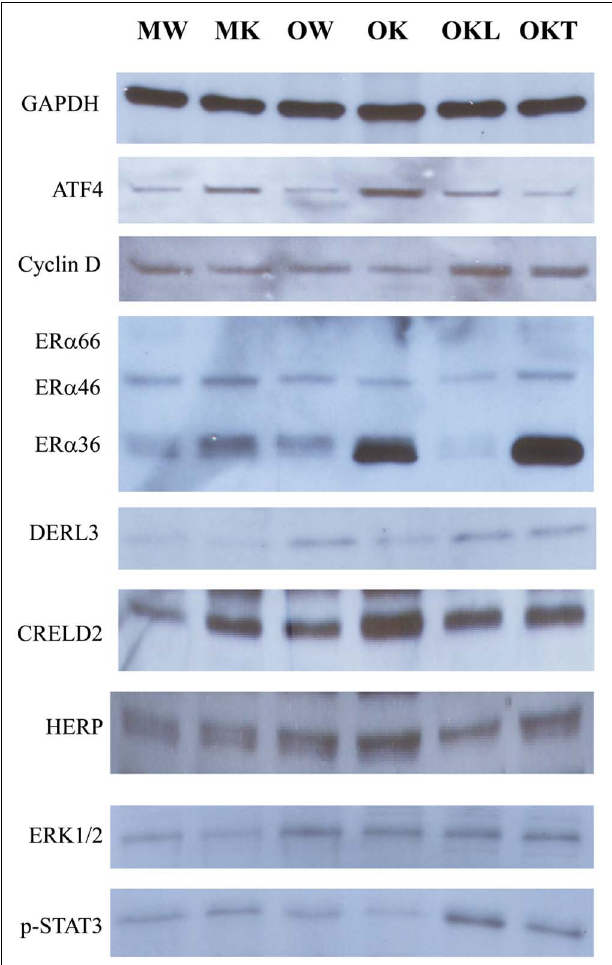
FIGURE 7 | Effects of alcohol and aging on ERAD and tumorigenesis pathways. ER α , estrogen receptor α variants (ER α 36, 46, and 66); p-ERK1/2, phosphorylated extracellular signal-regulated protein kinases 1 and 2; p-STAT3, phosphorylated signal transducers and activators of transcription; MW, middle-agedWT; MK, middle-aged KO; OW, olderWT; OK, older KO; OKL, the liver portion of tumor bearing livers of older KO; OKT, the tumor portion of tumor bearing livers of older KO.